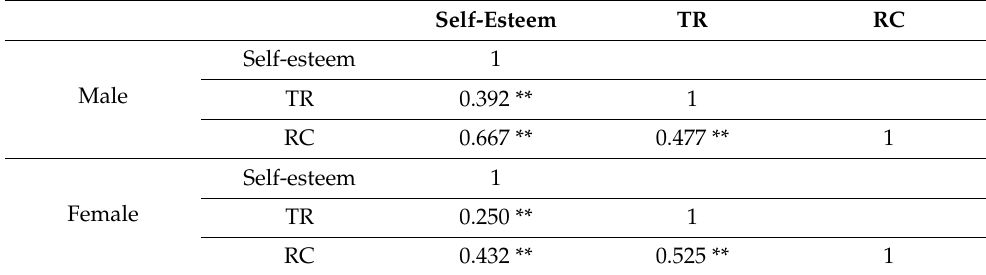
Table 2. Correlation between variables (N = 302). Self-Esteem TR RC Self-esteem 1 TR 0.305 ** 1 RC 0.533 ** 0.509 ** 1 gender 0.000 0.211 ** 0.094